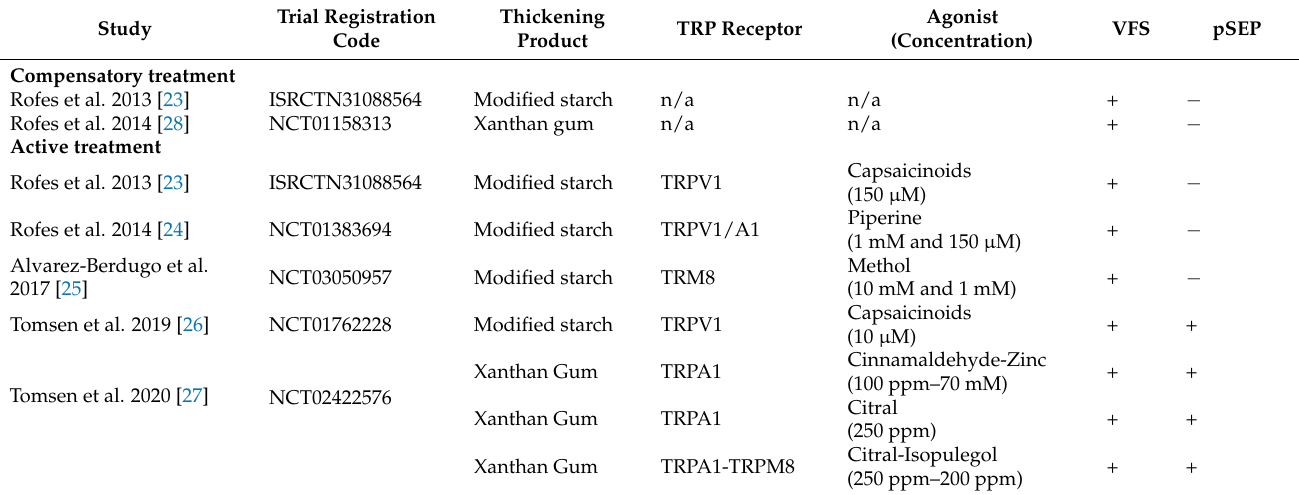
Table 4. Summary of the studies included in the comparative